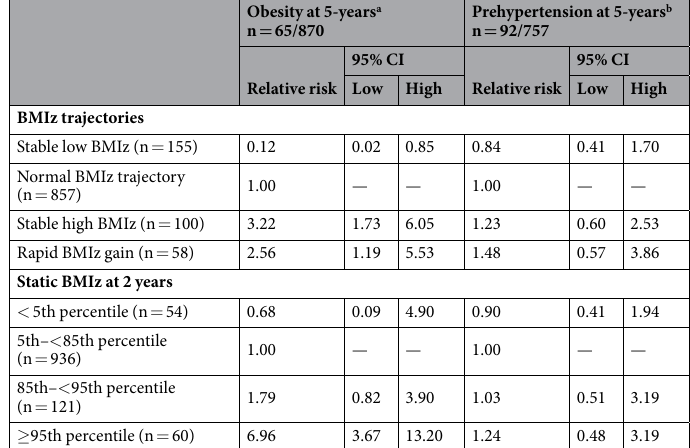
Table 4. Relative risk and 95% CI of child obesity and prehypertension at 5-years according to BMIz trajectories and static BMIz at 2 years. a Adjusted for maternal income level, ppBMI, height, GWG, parity, GA at delivery, breastfeeding and child ethnicity. b Adjusted for maternal income level, ppBMI, height, GWG, parity, GA at delivery, breastfeeding, blood pressure at 26–28 weeks of gestation and child